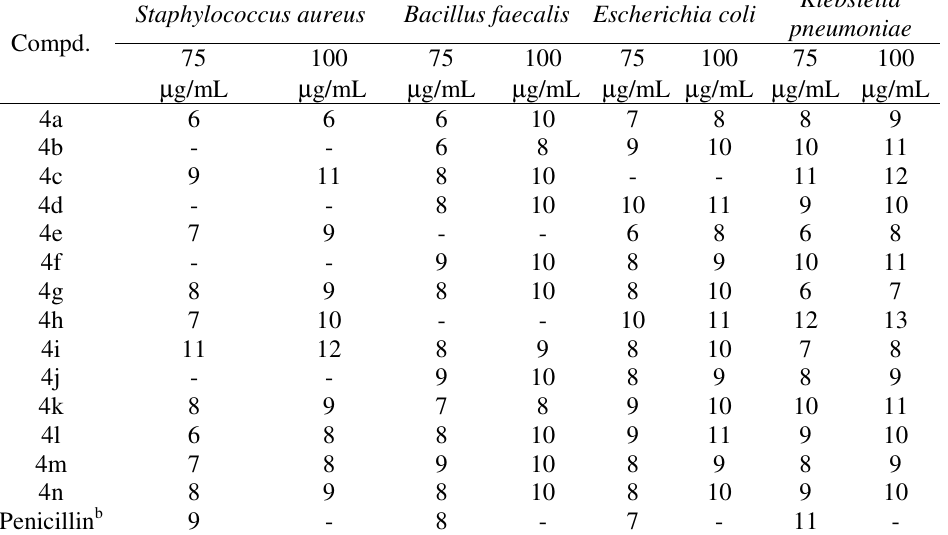
Table 5. Antibacterial activity a of new α -amino phosphonic acid esters (4a-n) Staphylococcus aureus Bacillus faecalis Escherichia coli